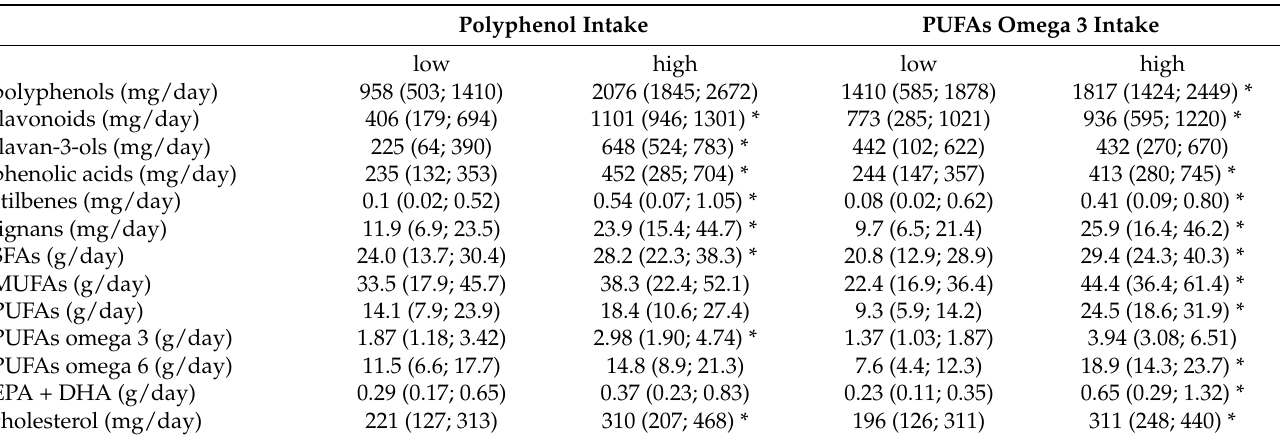
Table 2. Descriptive characteristic of dietary consumption of key food components in the T2DM patient groups with low and high polyphenol or PUFAs omega 3